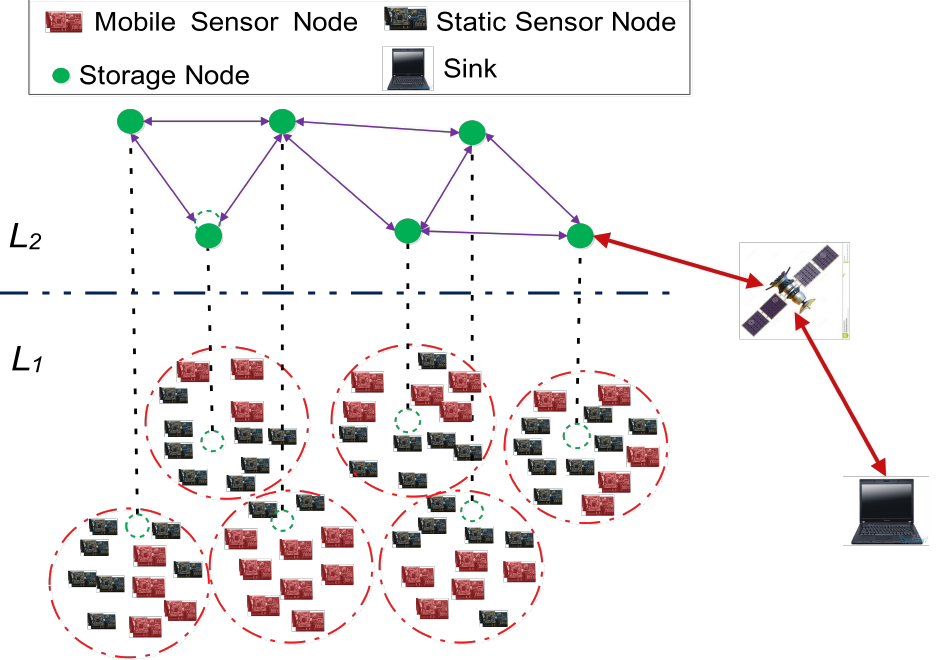
Figure 1. The network model of two-tiered mobile wireless sensor networks